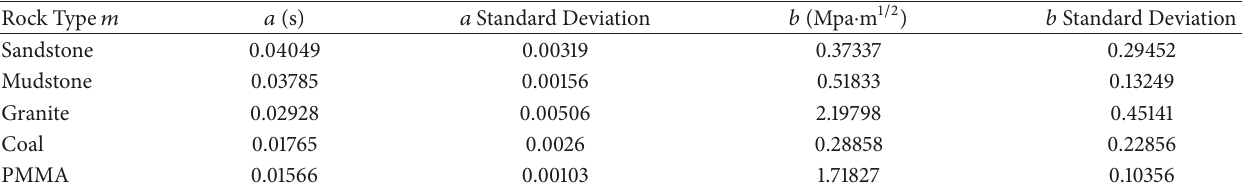
Table 2: Linear correlation coefficients for the fitting curve of fracture toughness-loading rate.